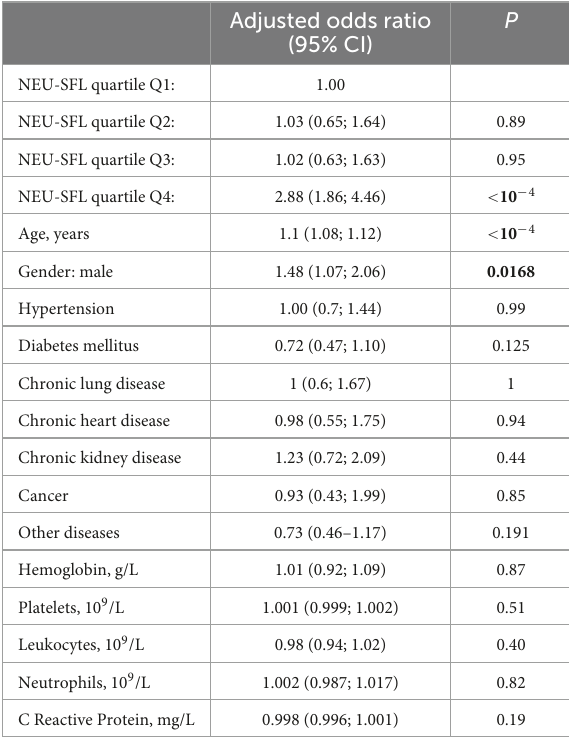
TABLE 2 Association between NEU-SFL index values at admission and death of patients with COVID-19 considering the potential confounding influence of demographic, laboratory risk factors available for at least 90% of the patients and comordidities. Adjusted odds ratio (95% CI)